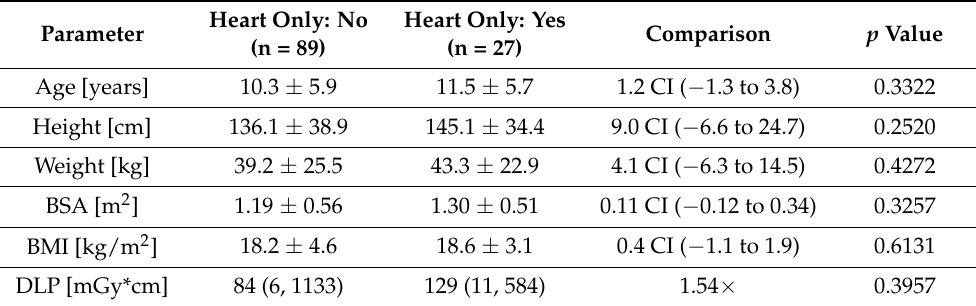
Table 2. Influence of the extent of scanning in the z -axis on the radiation dose of cardiac CT scan in